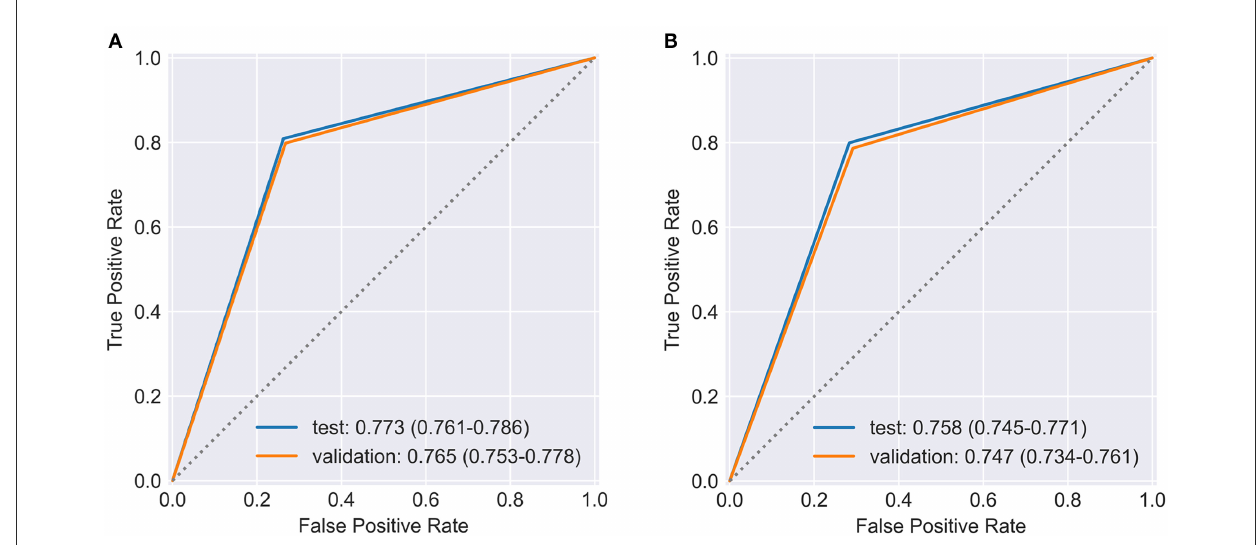
FIGURE1 ROC and AUC performed by (A) RF and (B) XGboost in Model IV for both testing set, and validation set.